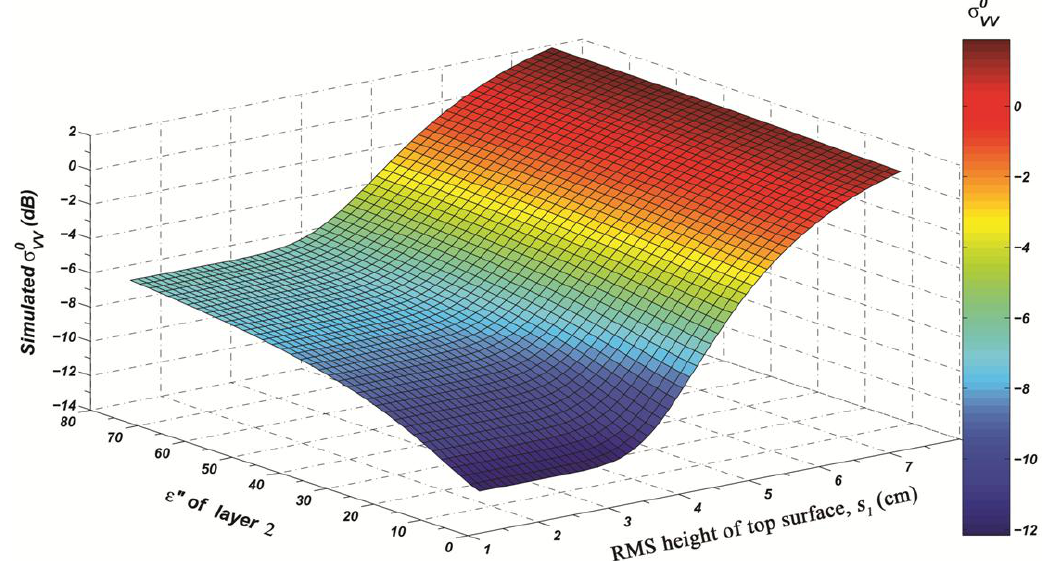
Figure 7. The variation patterns of simulated σ° (L-band, VV polarization, 25.6° incidence angle, ε s = 0.4 cm, l = 6.0 cm, thickness of layer 1 = 35 cm) with RMS height of top surface and εʹʹ 2 2 of layer 2. Different colors represent different levels, and corresponding color bar is shown.